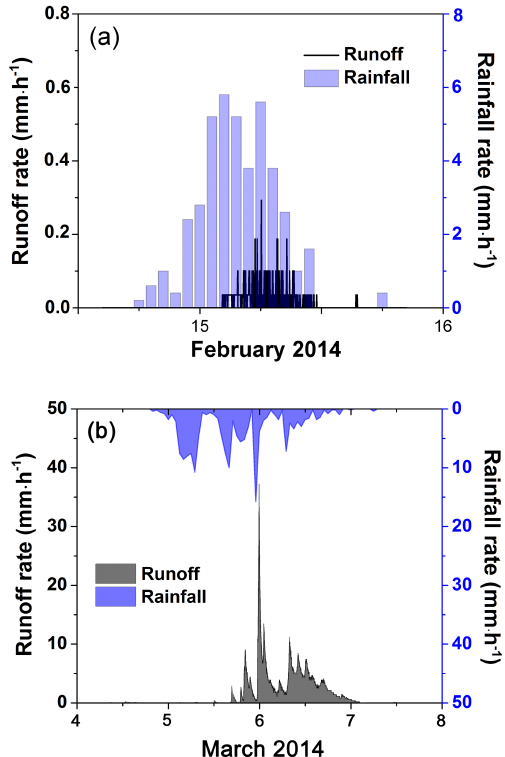
Figure 5. Examples of field applications of the UBeTube instru- ment in a long-term studymeasuring highway stormwater runoff produced by highway surfaces within western Oregon. (a) Data come from (a) state highway OR-18 near Otis, Oregon; and (b) state highway OR-34 near Alsea, Oregon. The left y axis shows the runoff ratemeasured by the instrument, and the right y axis shows the natural rainfall rate asmeasured by tipping bucket rain gauges installed at the sites.